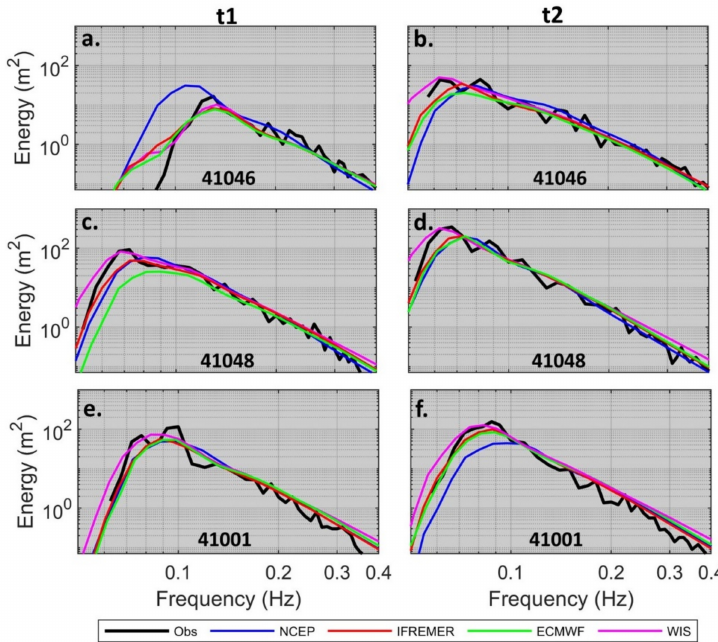
Figure 9. Buoy-model 1D wave spectra comparisons at ( a , c , e ) t1 and ( b , d , f ) t2 (see Figure 8) for buoys ( a , b ) 41046, ( c , d ) 41048, ( e , f ) 41001 during Hurricane Sandy.